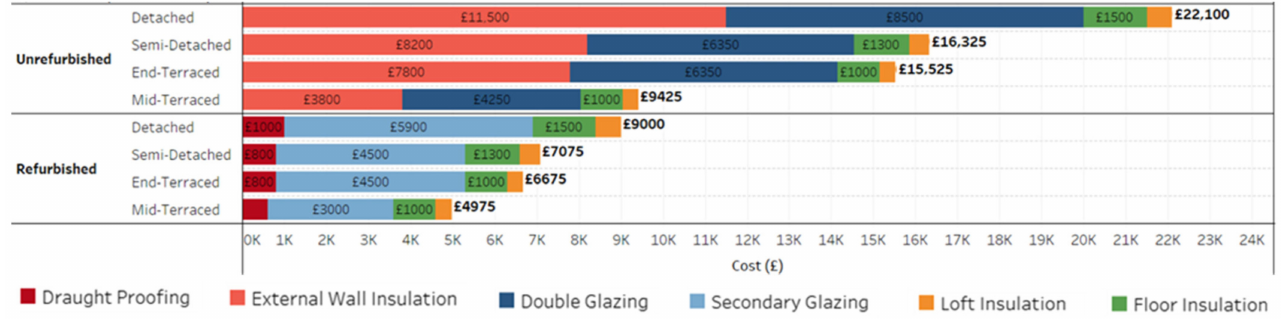
Figure A3. Breakdown of EEI costs by house archetypes and specifications.